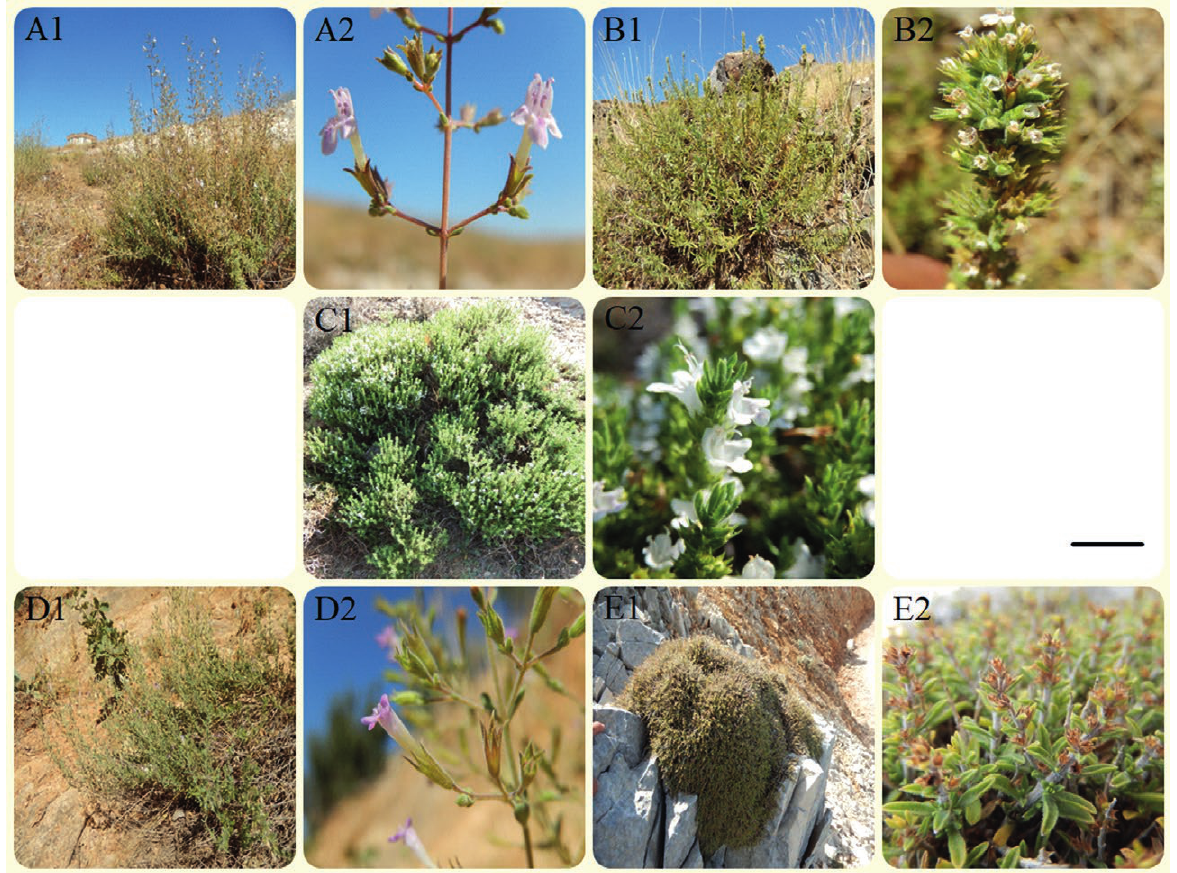
Figure 1. Habitat (1) and flowers (2) of Satureja species. (A) S. aintabensis ; (B) S. boissieri ; (C) S. icarica ; (D) S. macrantha ; and (E) S. spi- nosa . Scale bar, 10 cm for habitat (1) and 5 mm for flowers (2).